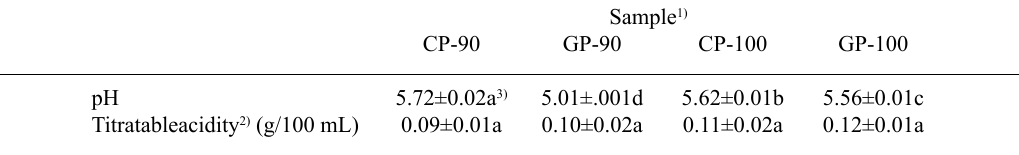
table 1. pH and titratable acidity of cultivated Pu-erh (CP) and Gushu Pu-erh (GP) tea